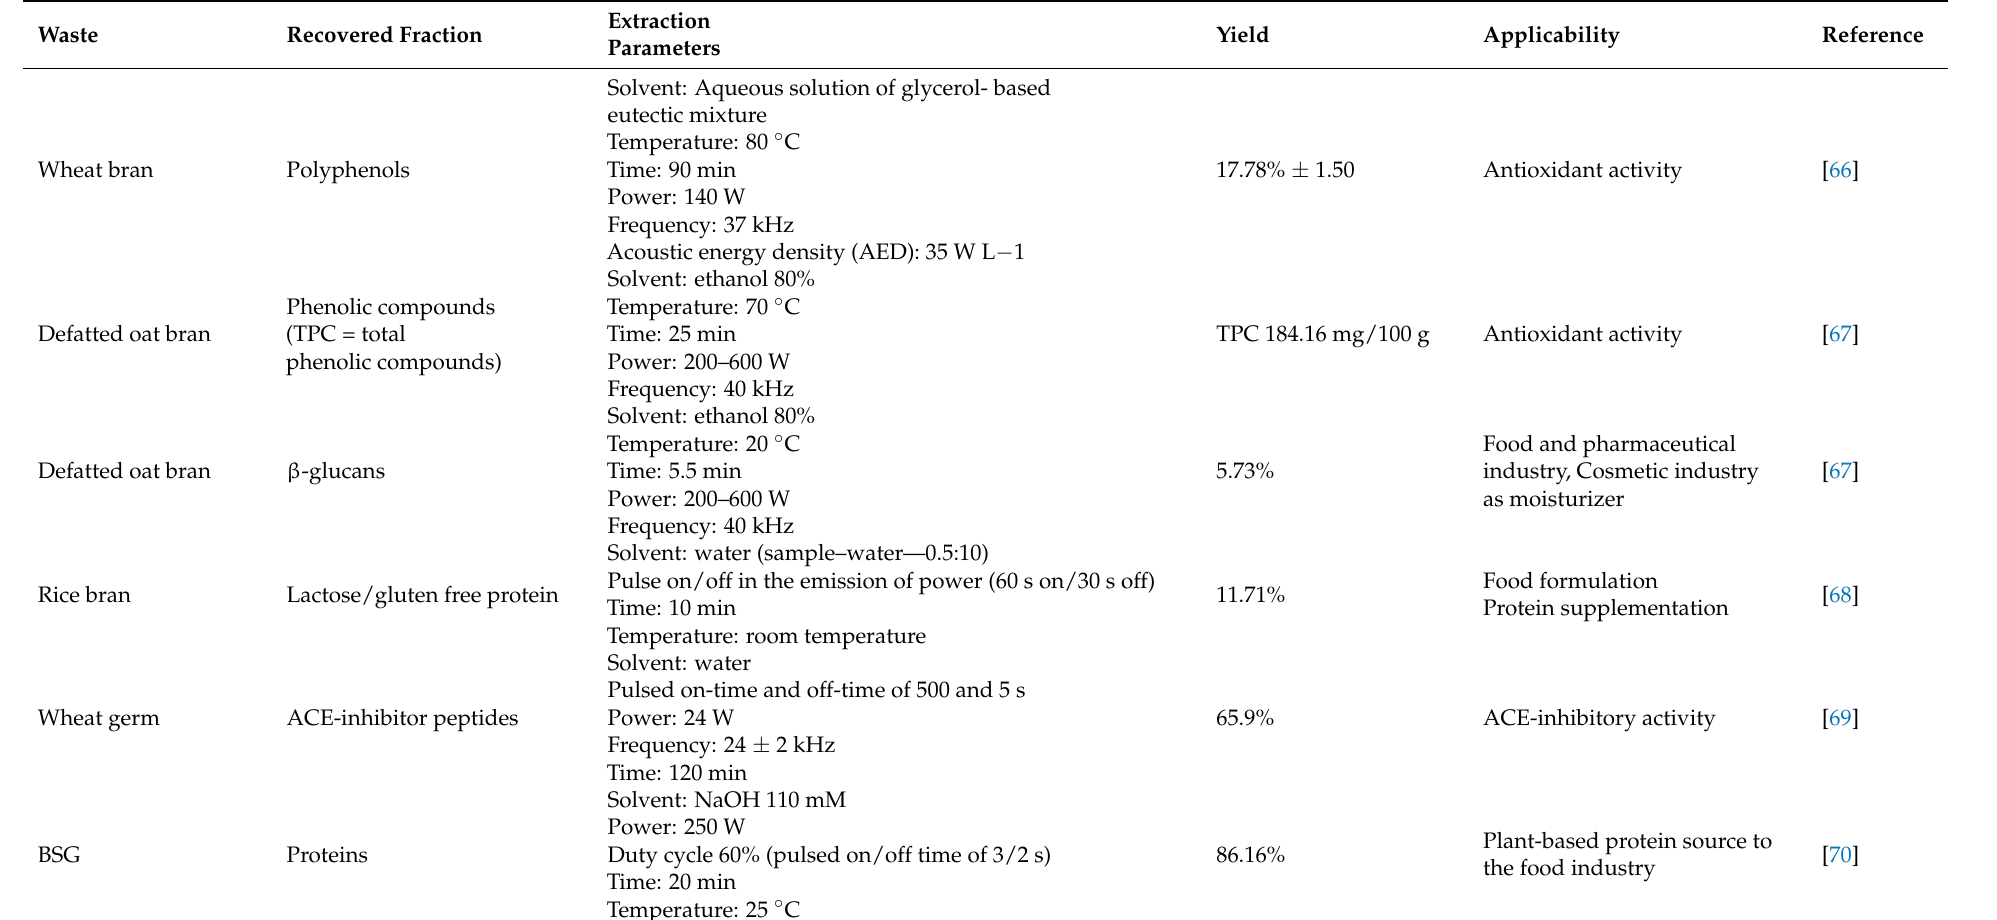
Table 3. The main fractions from cereal waste recovered using